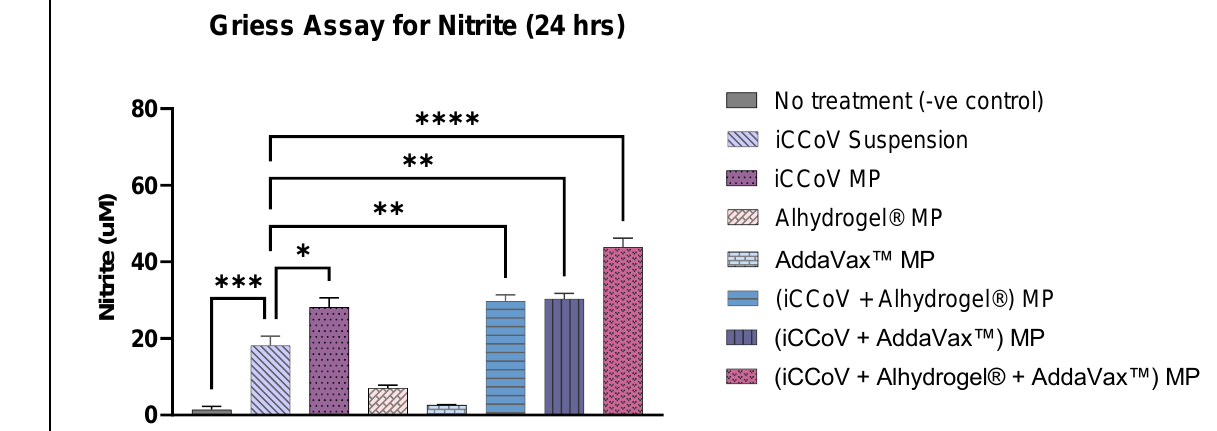
Figure 4. Nitrite release from DCs following treatment with MP . Cell density was adjusted to 3 × 10 4 cells/well and then treated with the following groups for 24 h: No Treatment (-ve control), iCCoV suspension (2 μg), iCCoV MP (2 μg), Alhydrogel ® MP (3 μg), AddaVax™ (0.5 μg), iCCoV MP (2 μg) + Alhydrogel ® MP (3 μg), iCCoV MP (2 μg) + AddaVax™ (0.5 μg) MP, iCCoV MP (2 μg) + Alhydrogel ® MP (2 μg) + AddaVax™ (0.5 μg) MP. The nitrite release in the supernatant was assessed using the Griess assay. Data are expressed as mean ± SEM ( n = 3), One-way ANOVA test, Post hoc Dun- nett’s multiple comparisons test, * p ≤ 0.05, ** p ≤ 0.01, *** p ≤ 0.001, and **** p ≤ 0.0001.